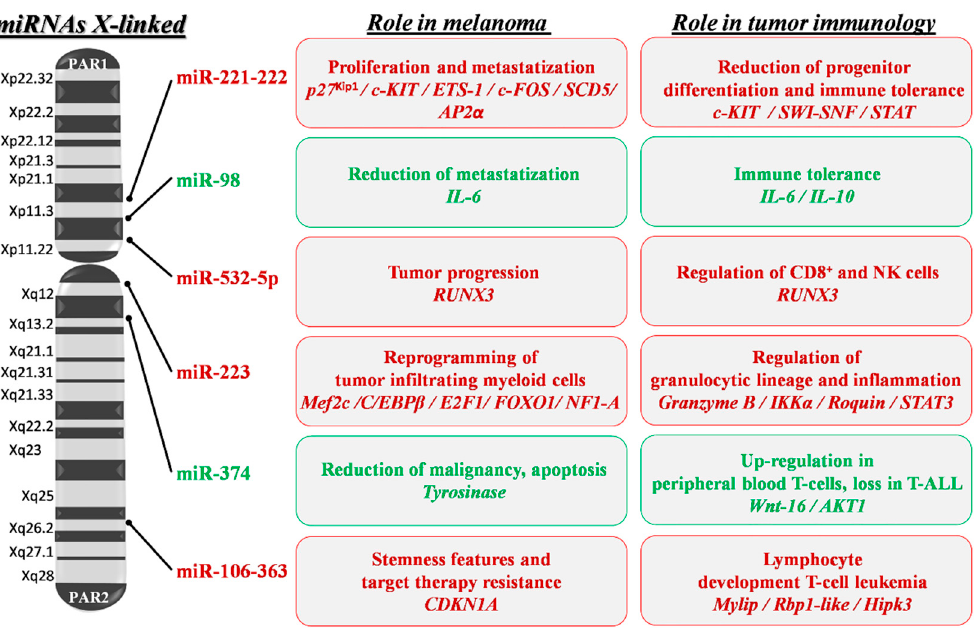
Figure 3. X-linked miRNA mapping and key roles in melanoma development and progression. Schematic depiction of miRNA localization on the human X chromosome: miRNAs with a confirmed role in melanoma pathogenesis are shown. Red writing inside boxes indicate miRNAs, target genes (italics) and their downstream oncogenic effects; green writing indicates those with oncosuppressive functions. PAR1 and 2: pseudoautosomal region 1 and 2; p27 Kip1 : cyclin-dependent kinase inhibitor